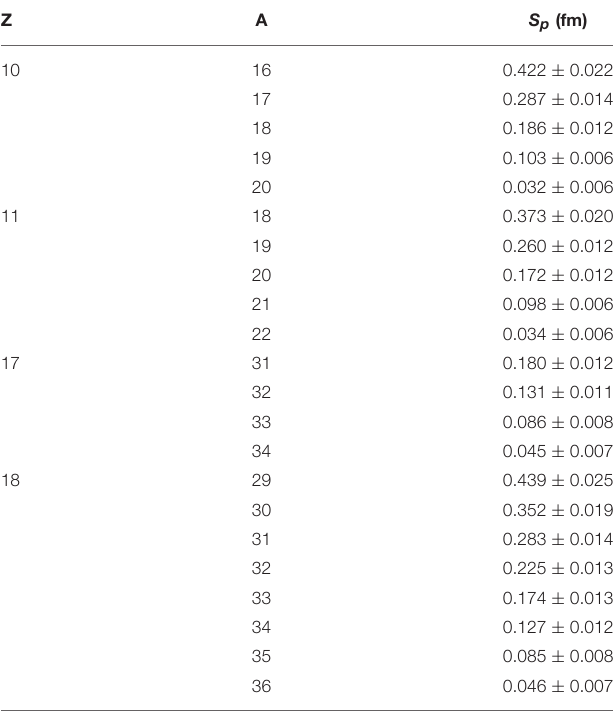
TABLE 1 | Proton skins, S p , for Z = 10, 11, 17, and 18 isotopic chains.